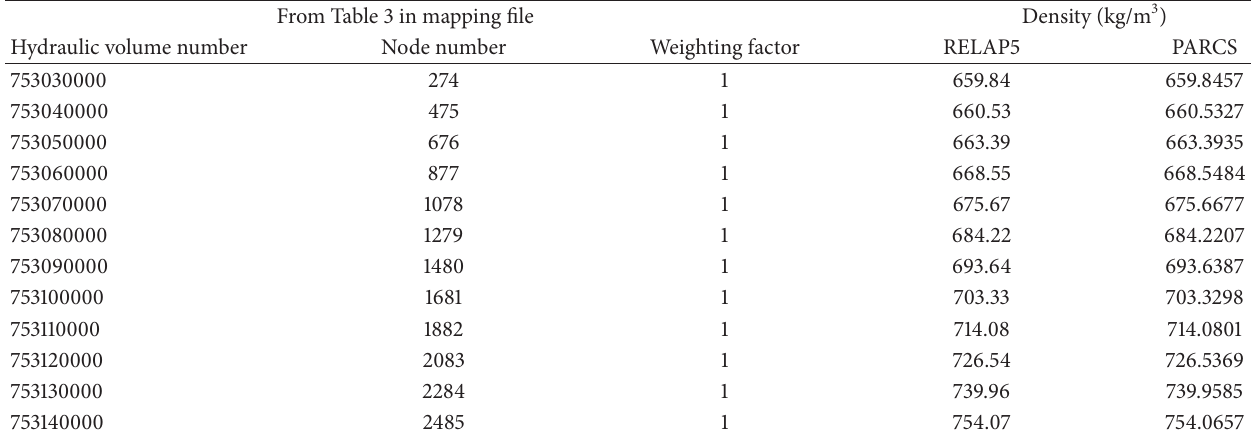
Figure 5: Comparison of cross sections from PARCS and HELIOS. Table 4: Densities from coupled PARCS node and RELAP5